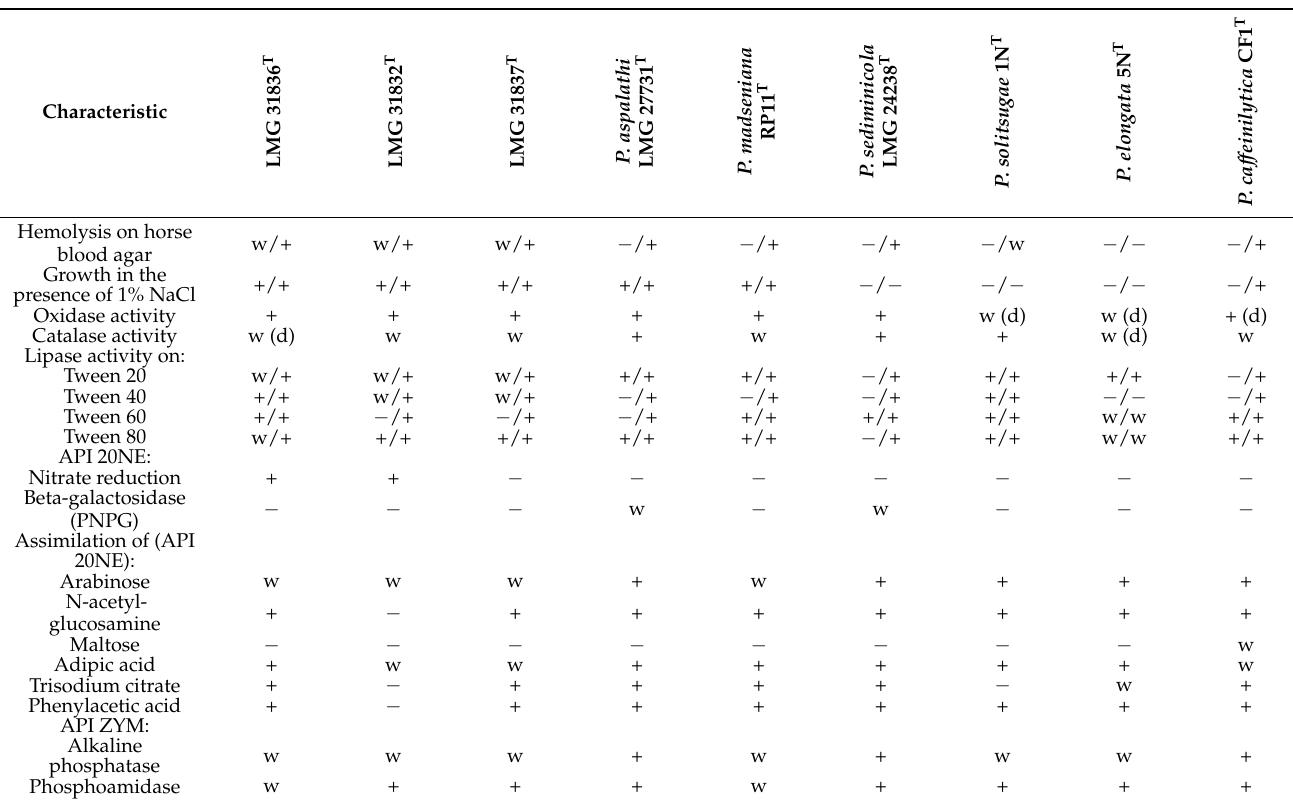
Table 6. Differential phenotypic characteristics of strains LMG 31836 T , LMG31832 T , LMG 31837 T and closely related type strains P. aspalathi LMG 27731 T , P. madseniana RP11 T , P. sediminicola LMG 24238 T , P. solitsugae 1N T , P. elongata 5N T and P. caffeinilytica CF1 T . All data are from the present study. +, positive reaction; w, weakly positive reaction; − , negative reaction; (d), delayed reaction. Results after 3 and 7 days are represented (3 days/7 days). Results of API 20NE and API ZYM microtests were read after 2 days and 4 h of incubation,